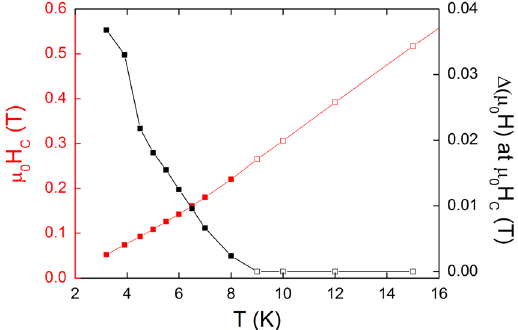
Fig. 3 Temperature dependence of critical magnetic fi eld μ 0 H c and size of hysteresis Δ μ 0 H c at H c for UCo 0.995 Ru 0.005 Al for fi eld applied along the c -axis. Filled symbols indicate fi elds at which a fi rst-order transition is observed ( H c determined as an average of fi eld up and fi eld down values), open symbols corresponds to a second-order